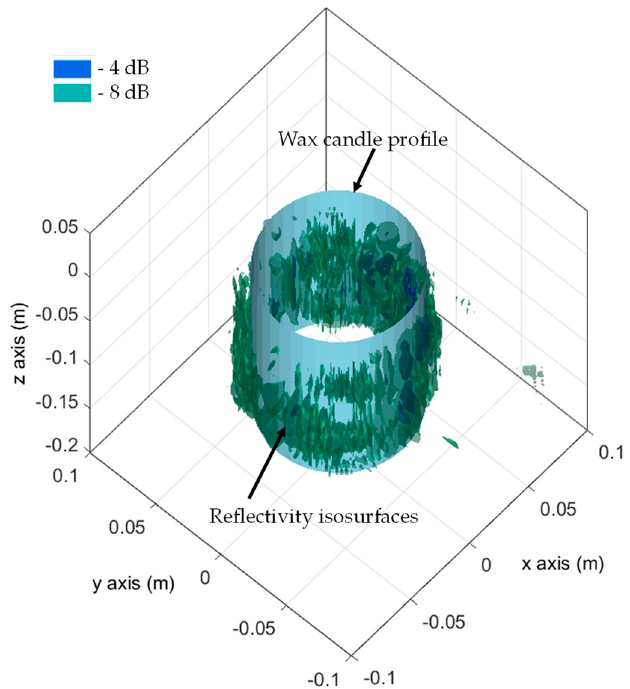
Figure 8. 3D representation of the recovered reflectivity of the wax candle, after dielectric delay correction.